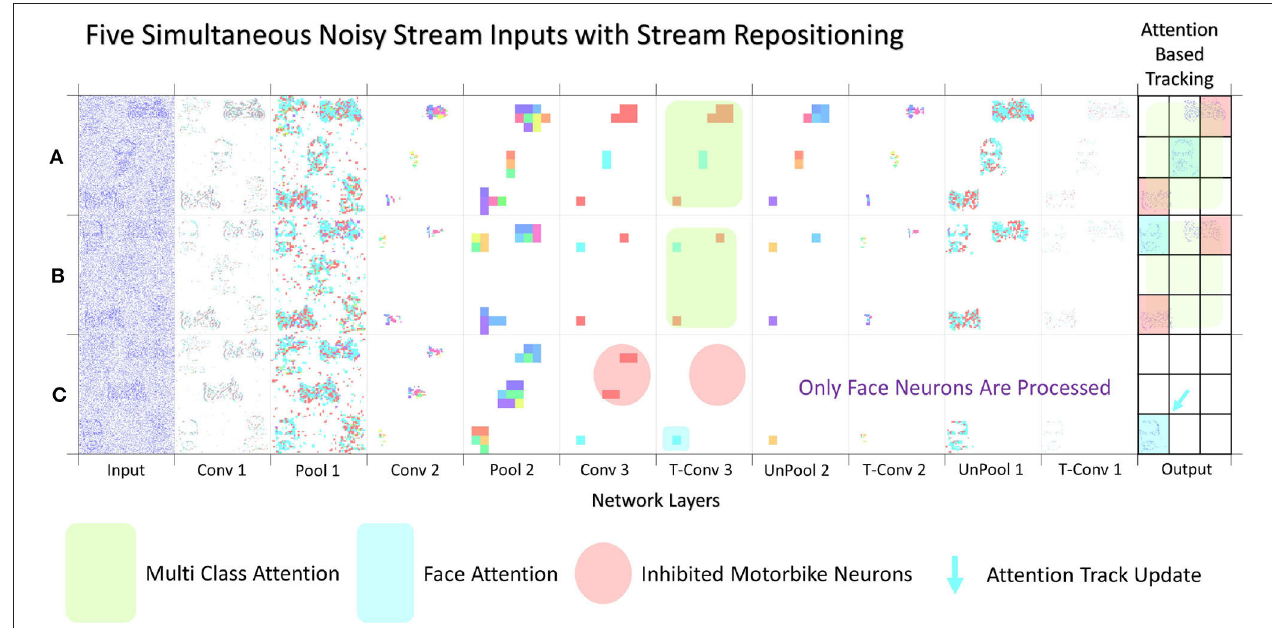
FIGURE 11 | Image showing three separate multi input data streams. (A,B) both representing the full system layer-wise computations when no attention is selected, while (C) shows the layer-wise computation after the Face class has been selected as the attention of the network, thus enabling a simplification of the output and activating the action part of the system with a tracking controller update.